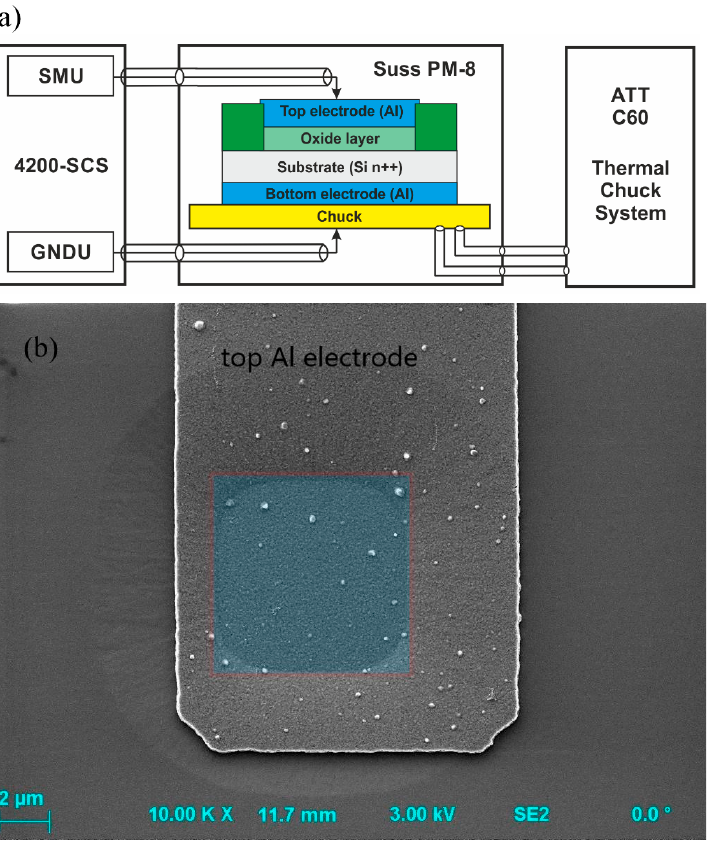
Figure 1. Schematic sketch of the investigated structure and measurement setup used for electrical characterization ( a ) and a top-view SEM photo of an investigated device with shaded device area ( b